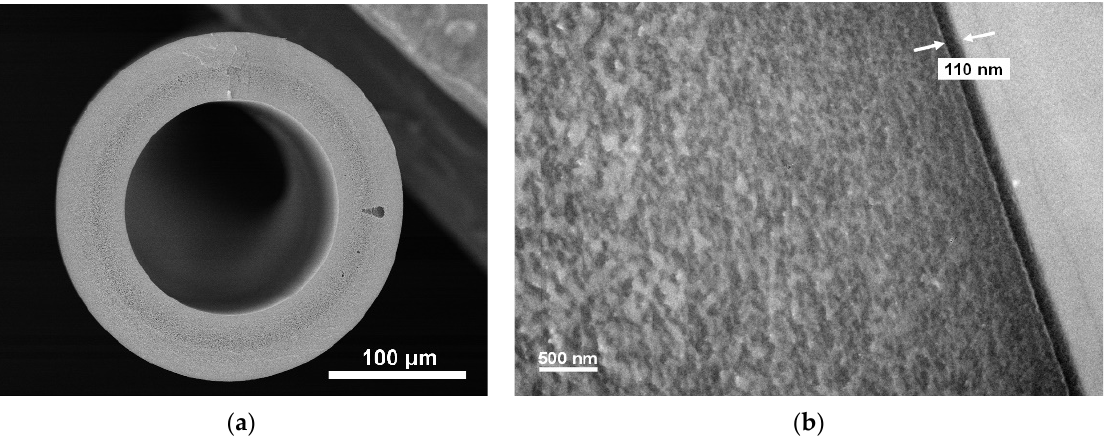
Figure 3. Scanning electron microscopy images of SPN-20/PPO hollow-fiber membranes: ( a ) entire cross-sectional view and ( b ) cross-section near the outer surface of the membrane. The thickness of the SPN-20 layer was 110 nm. Table 1. Properties of SPN-20/PPO hollow-fiber membranes [22].